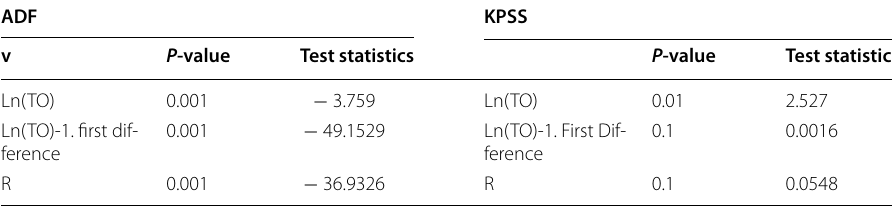
Table 2 ADF and KPSS unit root test